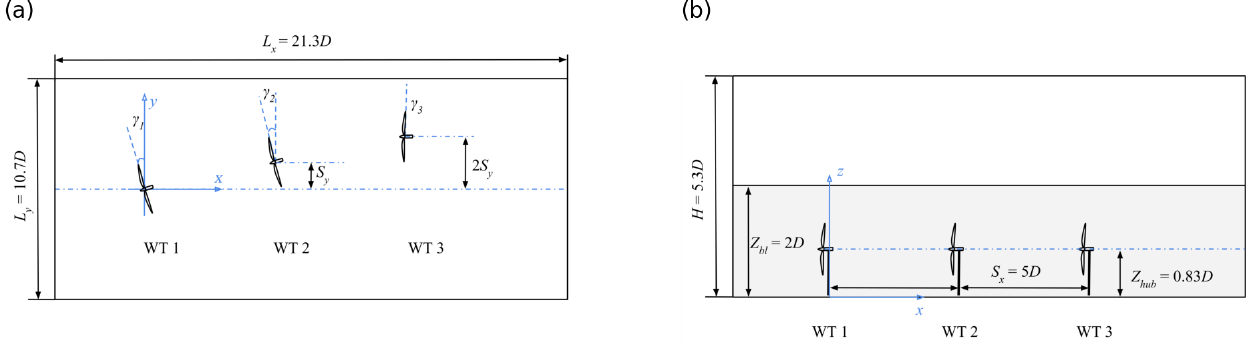
Figure 2. Schematic plots of the simulation domain (not to scale): (a) top view; (b) side view.